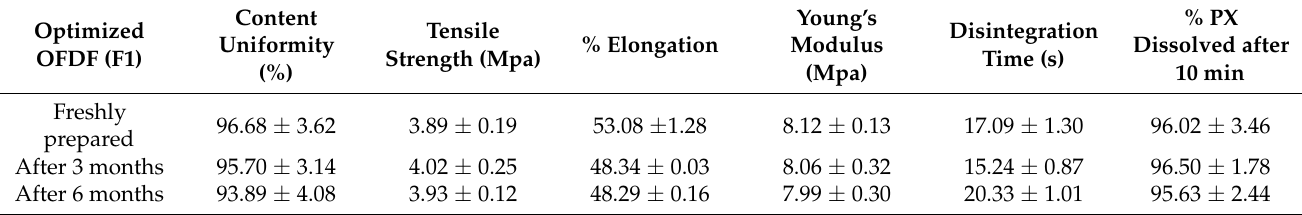
Table 4. Stability test parameters for the optimized OFDF